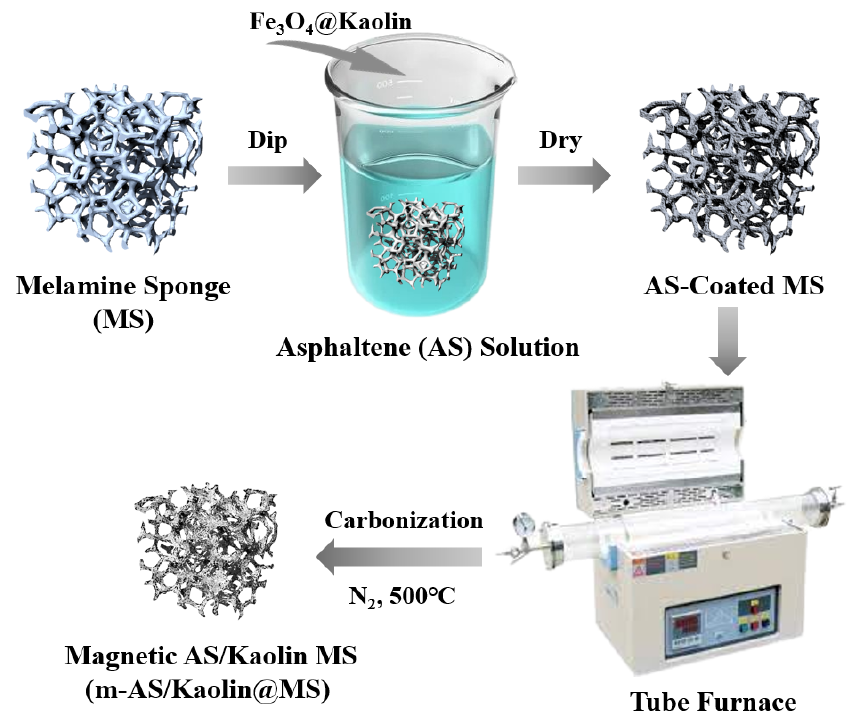
Figure 1. Schematic illustration of the fabrication process of the m-As/Kaolin@MS.